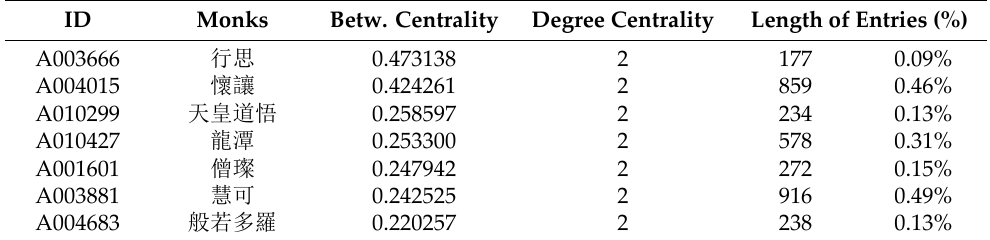
Table 7. Figures with a high betweenness centrality, low degree centrality, and relatively short entry in the ZTJ . Total length of the entries: 3274 characters